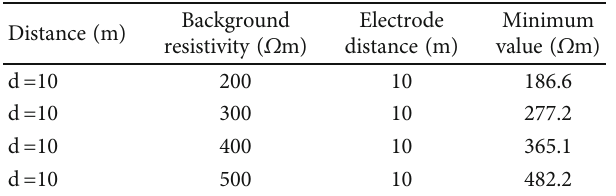
Figure 8: (a) Comparison of apparent resistivity of circular tunnel and square tunnel. (b) The relative error. Table 1: The e ff ect of the background resistivity on the electrode distance of minimum point.